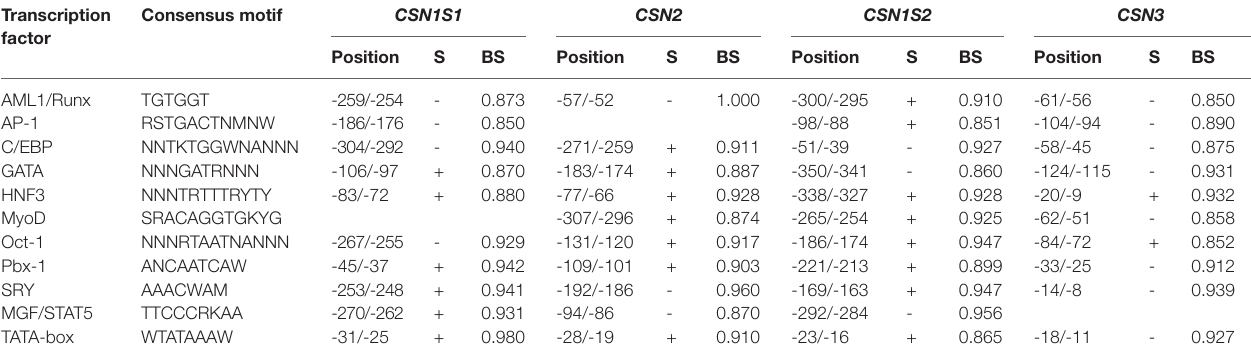
TABLE 6 | Most representative consensus motifs for transcription factors detected in the 5’-flanking regions of camelids by TFBIND software and present in all caseins with higher binding score (BS). DNA strands (S) in direction 5’ > 3’ are indicated by +. The opposite strands are indicated by